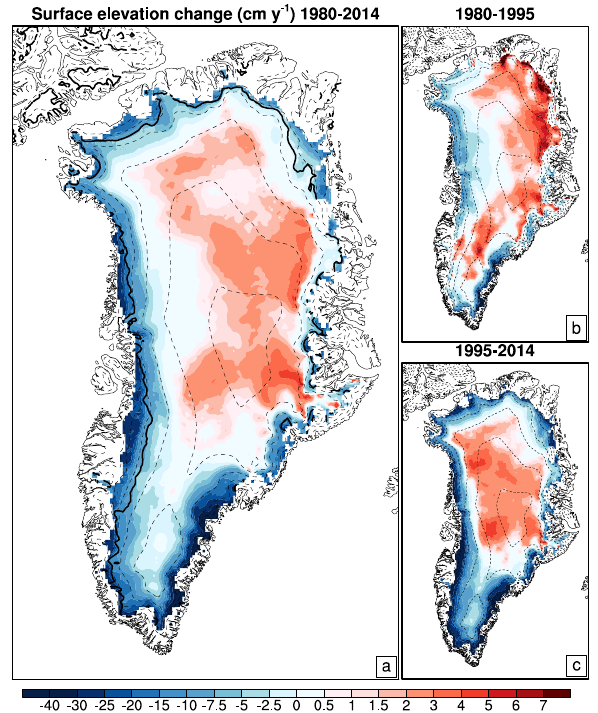
Figure 6. Modelled firn air content F on 1 September 2014 (in m). Dashed contour lines at 500m height intervals.